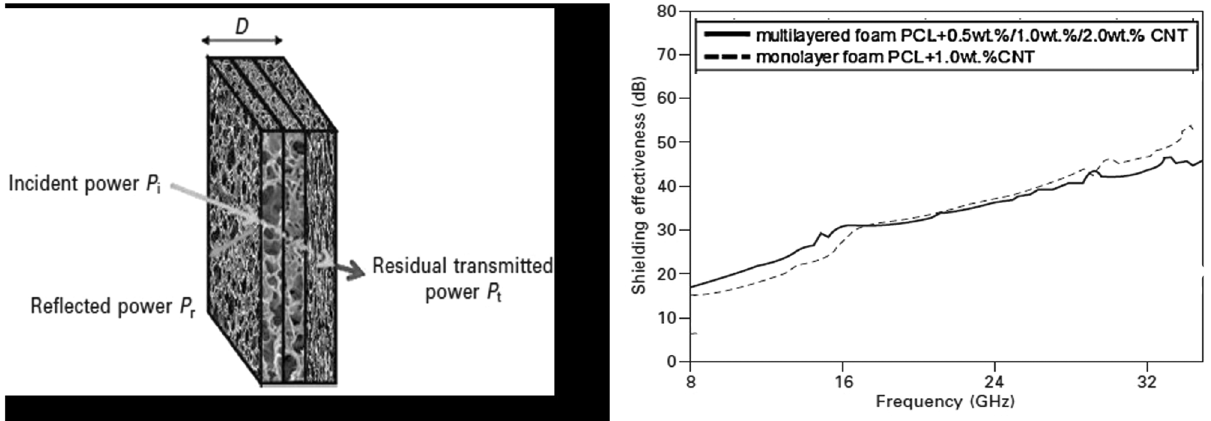
Figure 7: Re fl ection and SE of a three - layered MWNT/PCL nanocomposite foam ( left ) . SE of a single CNT concentration: 1 wt% ( dashed ) compared with a three - layered sample with graded CNT concentration ( bold lines ) : 0.5 wt% ( 11 mm ) /1 wt% ( 2 mm ) /2 wt% ( 17 mm ) ( right ) [ 107 ]